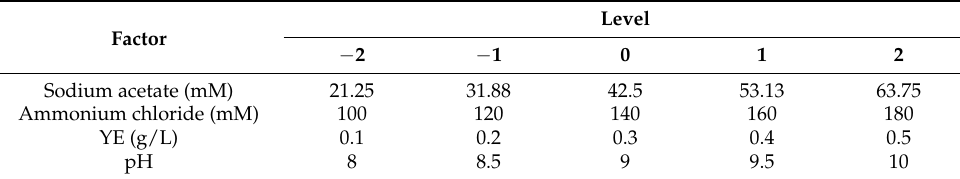
Figure 5. Effect of each key factor on urease activity: ( a ) sodium acetate; ( b ) ammonium chloride; ( c ) YE; and ( d ) pH. Table 5. Factors and levels of the CCD